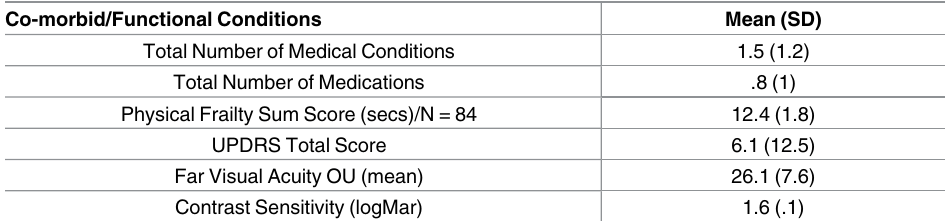
Table 2. Summary of Functional Assessment/Co-morbidities (N = 129).